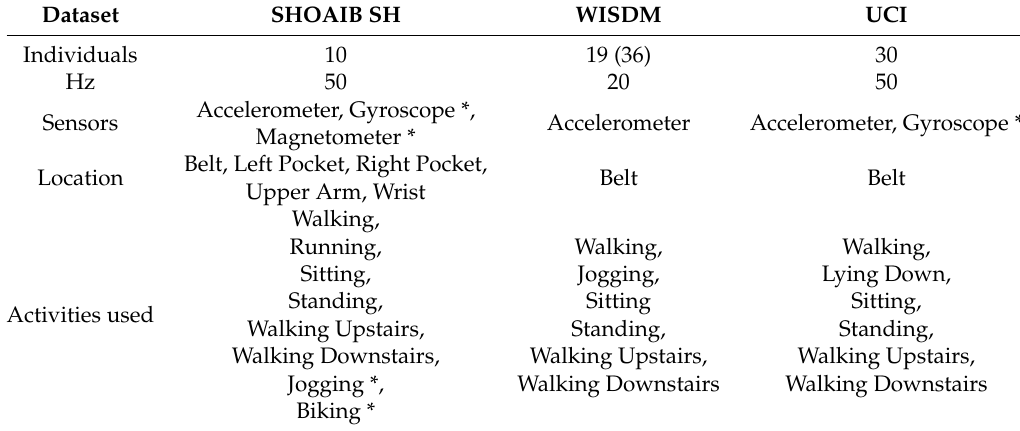
Table 4. Summary of dataset characteristics used in experiments. The Jogging and Biking activities (marked with ∗ ) were removed from our experiments. The gyroscope and magnetometer sensors were used only in specific